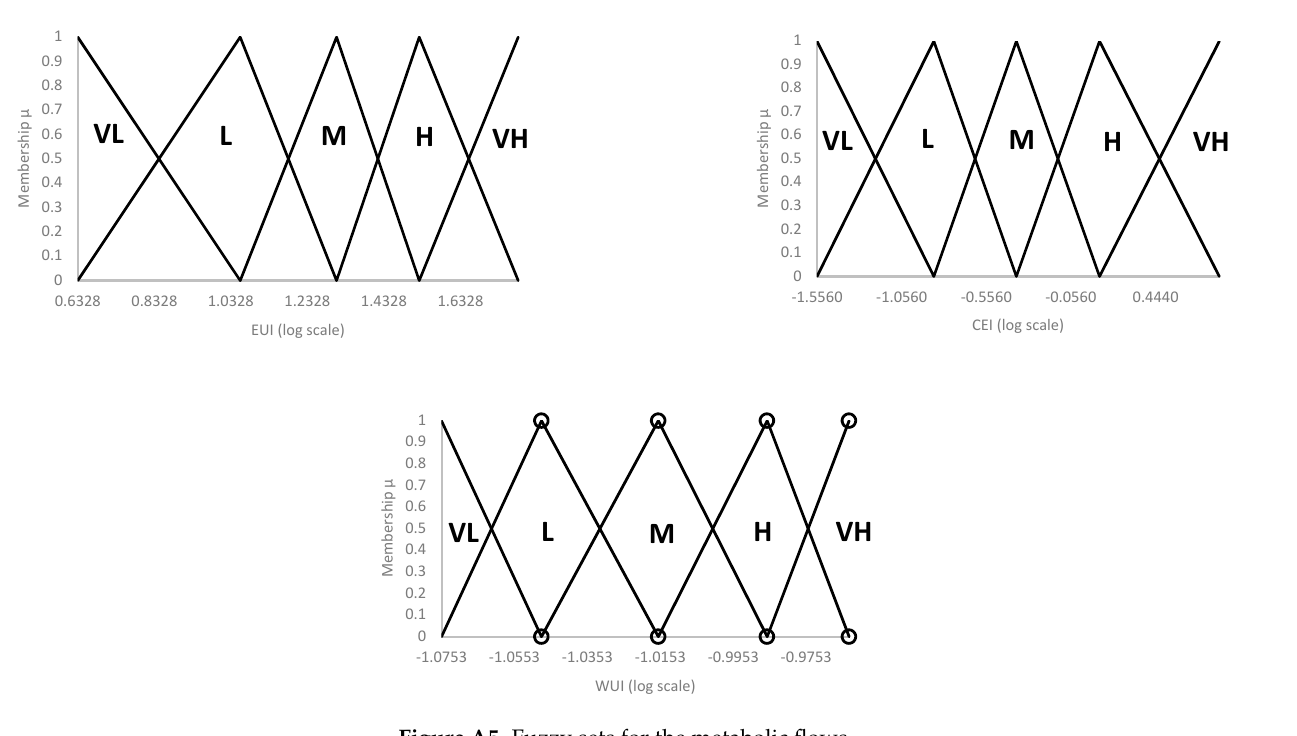
Figure A5. Fuzzy sets for the metabolic flows. Table A2. AHP weights and the scenarios. Scenaior 1: Water Preference Weight